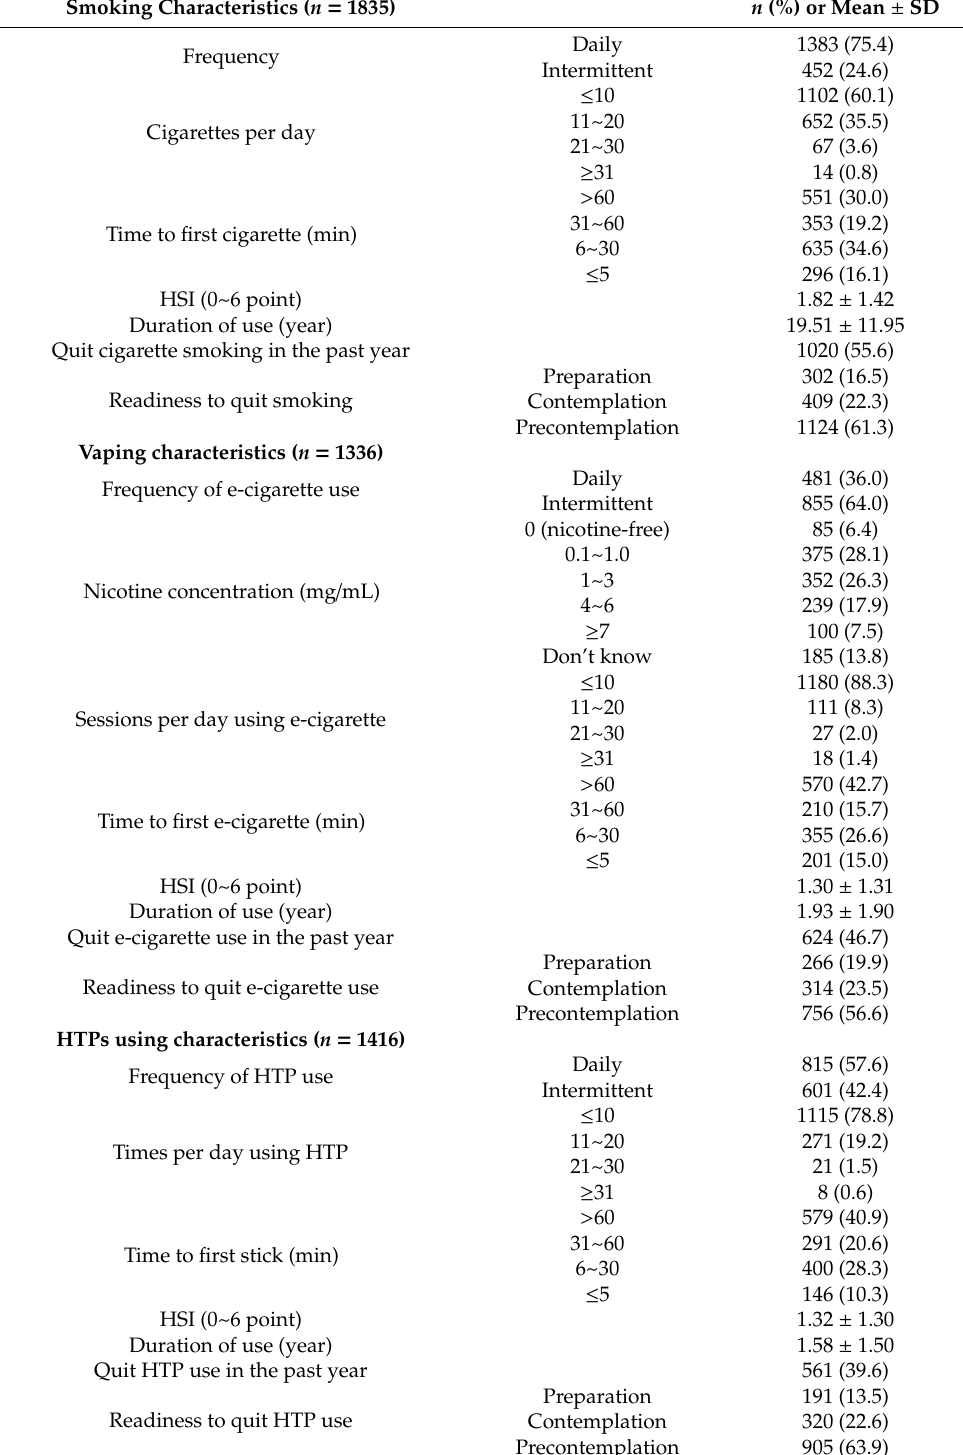
Table 2. Tobacco use